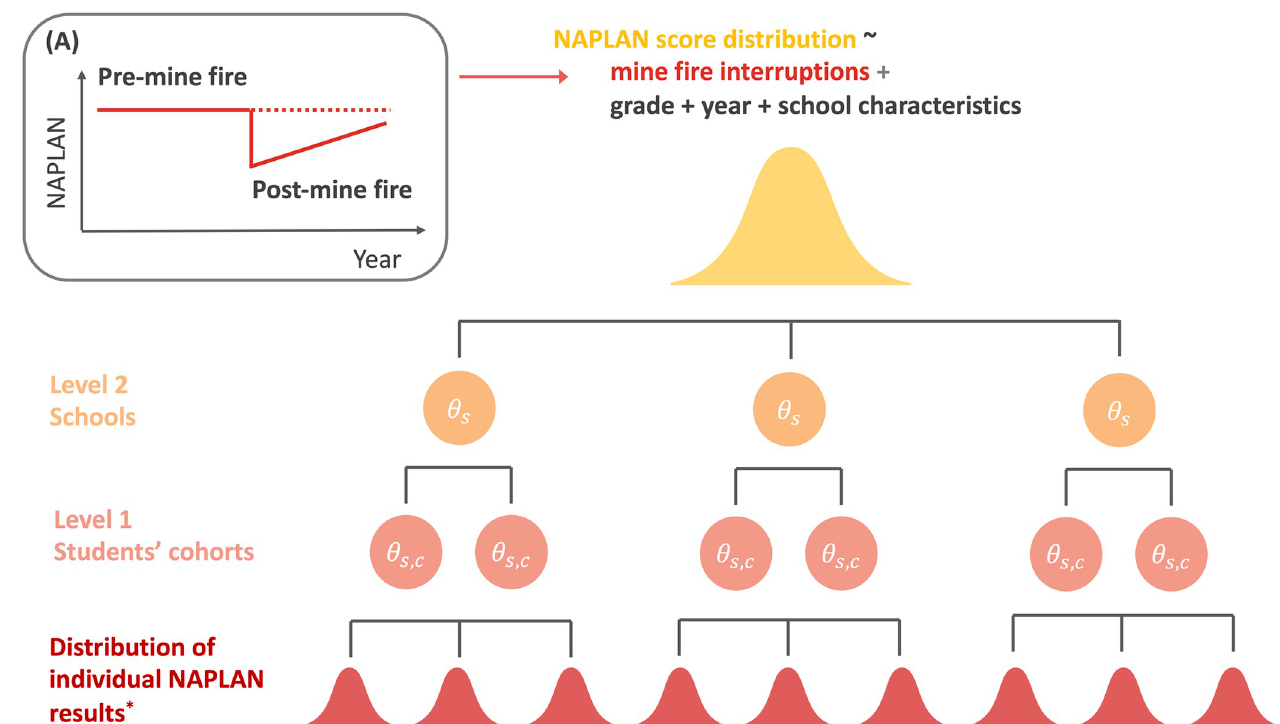
Fig 2. Illustration of Bayesian interrupted time series hierarchical meta-regression. � Means and SE of test results each year for individual students’ grade level at each school. The subgraph (A) represents a theoretic model of the mine fire interruption effect.